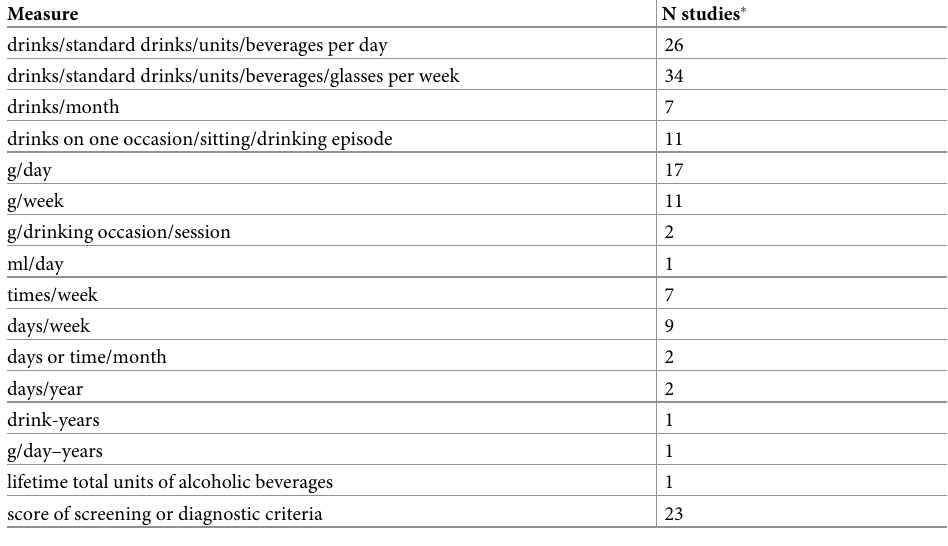
drink-years 1 g/day–years 1 lifetime total units of alcoholic beverages 1 score of screening or diagnostic criteria